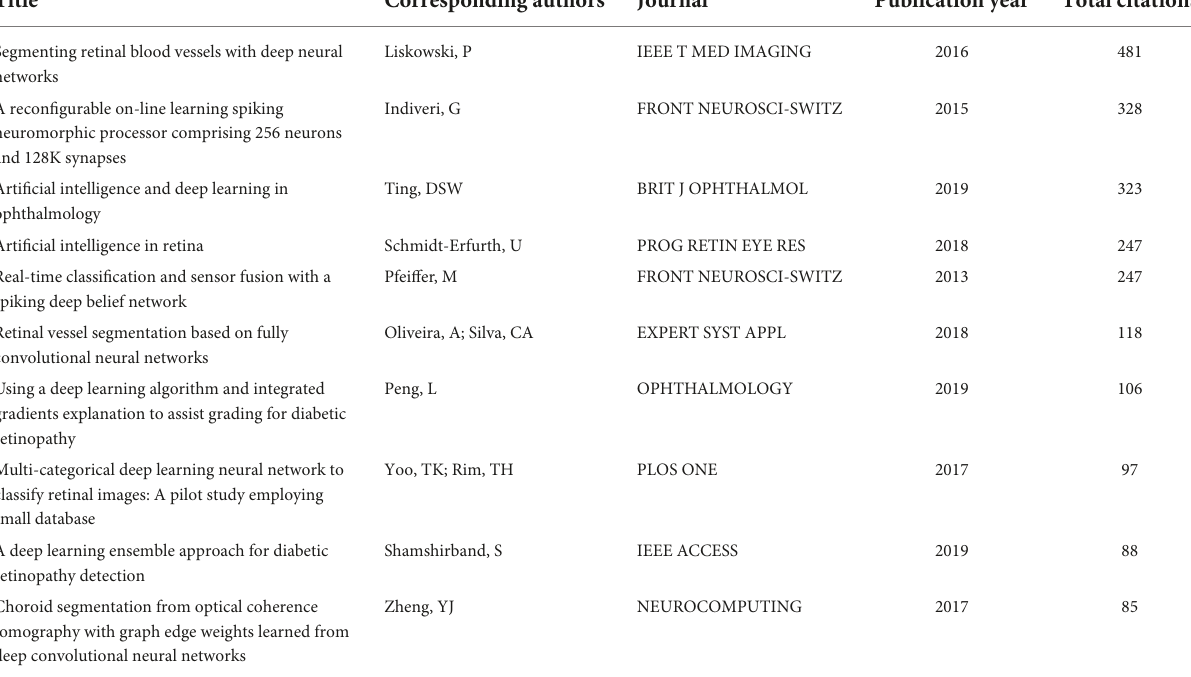
TABLE 1 The top 10 papers with the most citations relevant to artificial intelligence in retina.